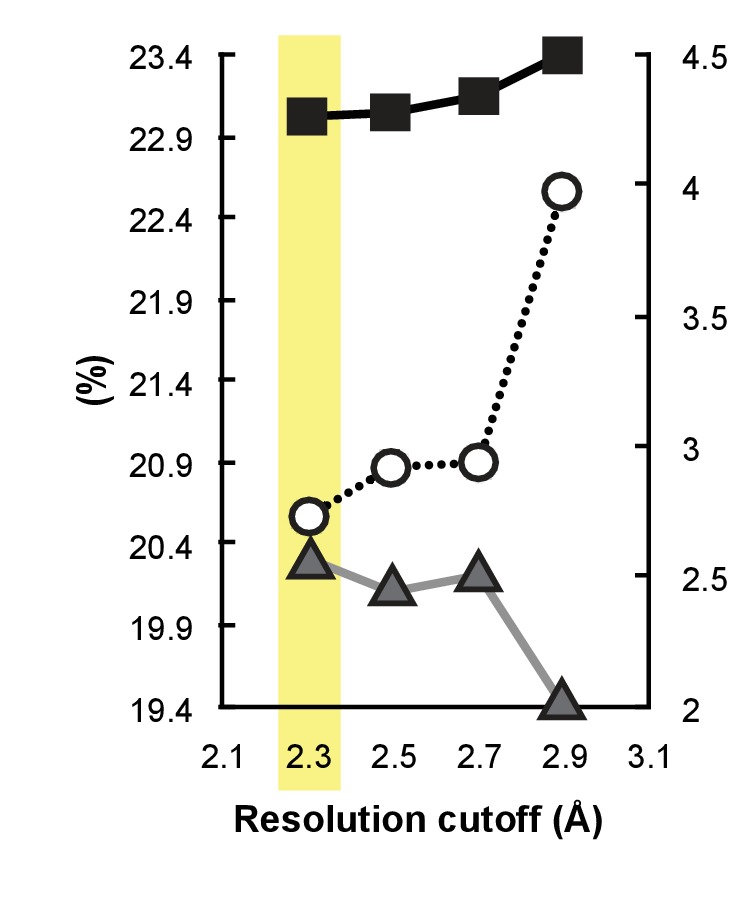
A paired refinement demonstrates that the extended resolution improves the quality of the model.Shown are Rfree (black line, solid squares), Rwork, (gray line, solid triangles), and Rfree-Rwork (dotted line, open circles) calculated at 2.9 Å for paired refinements in which the model was first refined against either 2.9, 2.7, 2.5, or 2.3 Å data. The chosen resolution cutoff of 2.3 Å (highlighted in yellow) show a decrease in Rfree and increase in Rwork, which proves that using the extra resolution improves the model.